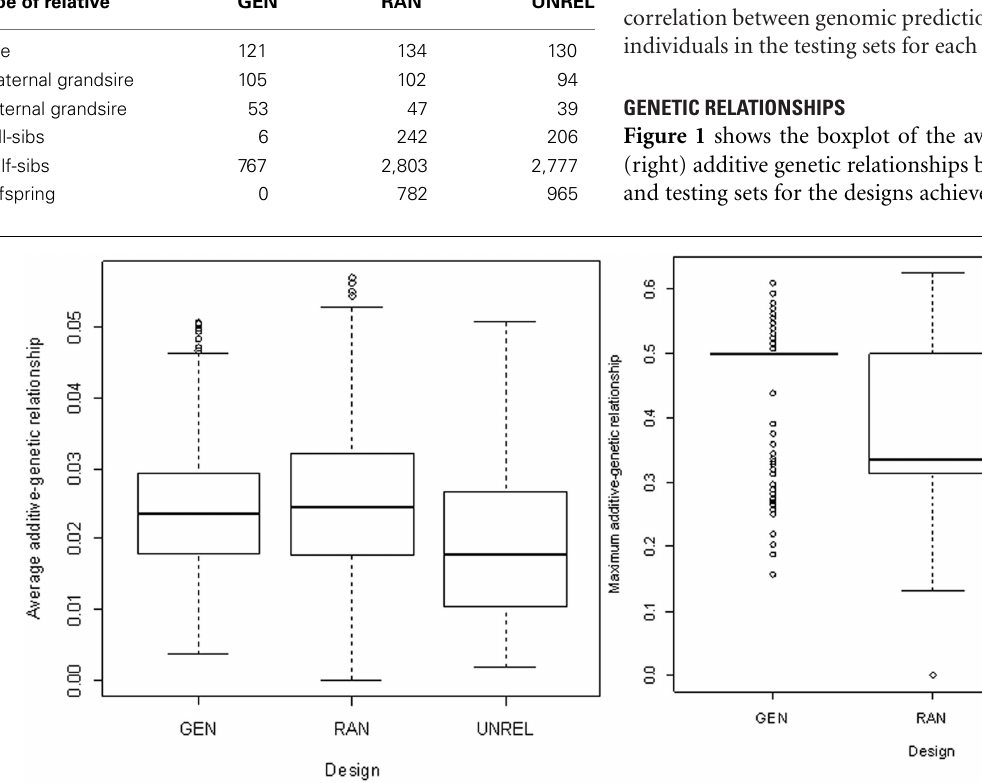
Table 1 | Relatives in the training set from testing bulls in the generational (GEN), random (RAN), and theA-matrix decomposition (UNREL) designs.